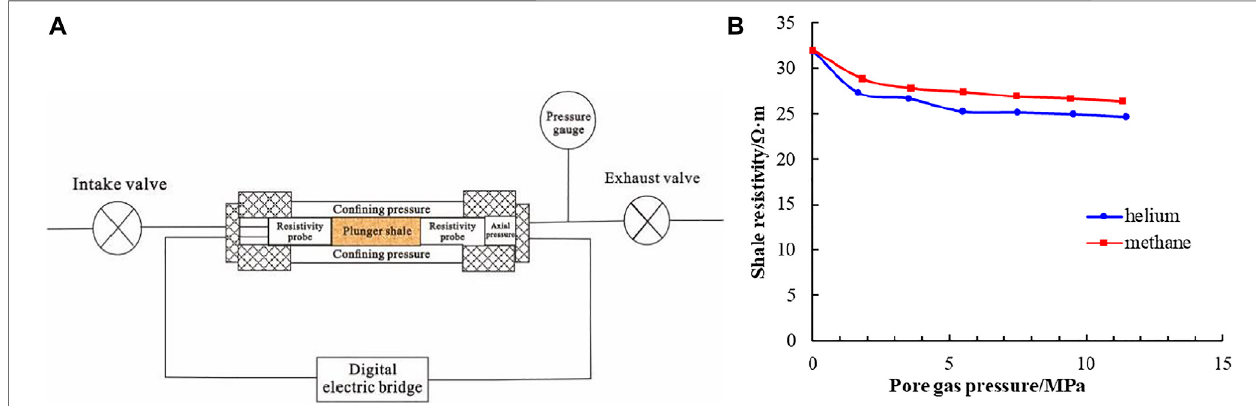
FIGURE 11 | (A) A self-developed combined isothermal adsorption and resistivity measurement device; (B) the relationships between pore gas pressures and shale resistivities.